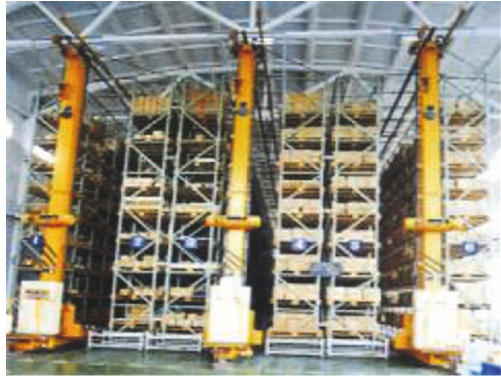
Figure 8: Stackers in State Grid Measuring Center of China. were simulated in ASRS. In order to verify the effectiveness of the proposed model, wavelet transform and box-plot are chosen to compare with the result of PCNN-wavelet model. The results were shown as Figure 10.